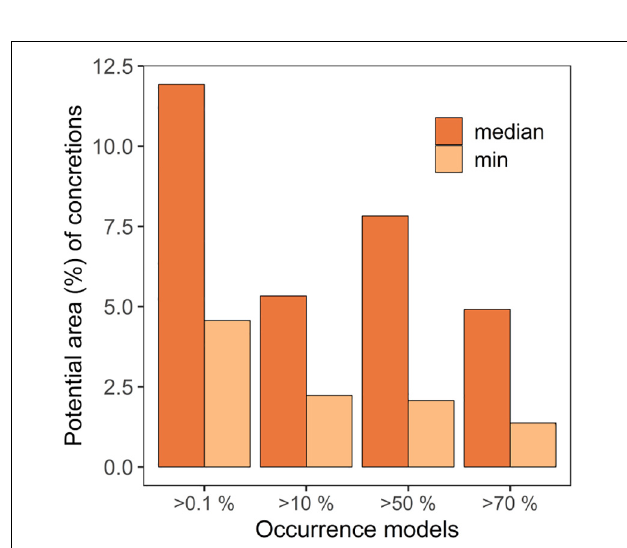
FIGURE 7 | Proportional surface area of the potential areas for FeMn concretions in Finnish marine areas.